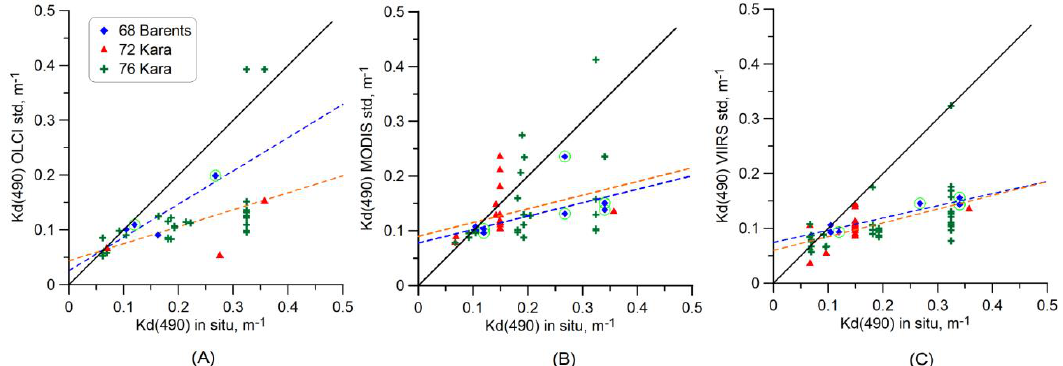
Figure 16. Scatterplot of the diffuse attenuation coefficient K d (490) values calculated from field measurements and satellite data (standard algorithm, nearest pixel): ( A ) OLCI; ( B ) MODIS; ( C ) VIIRS. Solid black line—perfect correspondence 1:1; dotted blue line—the regression line for the Barents Sea, AMK 68; dotted red line—the Kara Sea, AMK 72, and 76. Green circles show the stations with coccolithophore blooms. Table 9. Correspondence parameters between the K d (490) values obtained from field measurements (X) and satellite data (Y). Satellite data for the nearest pixel.